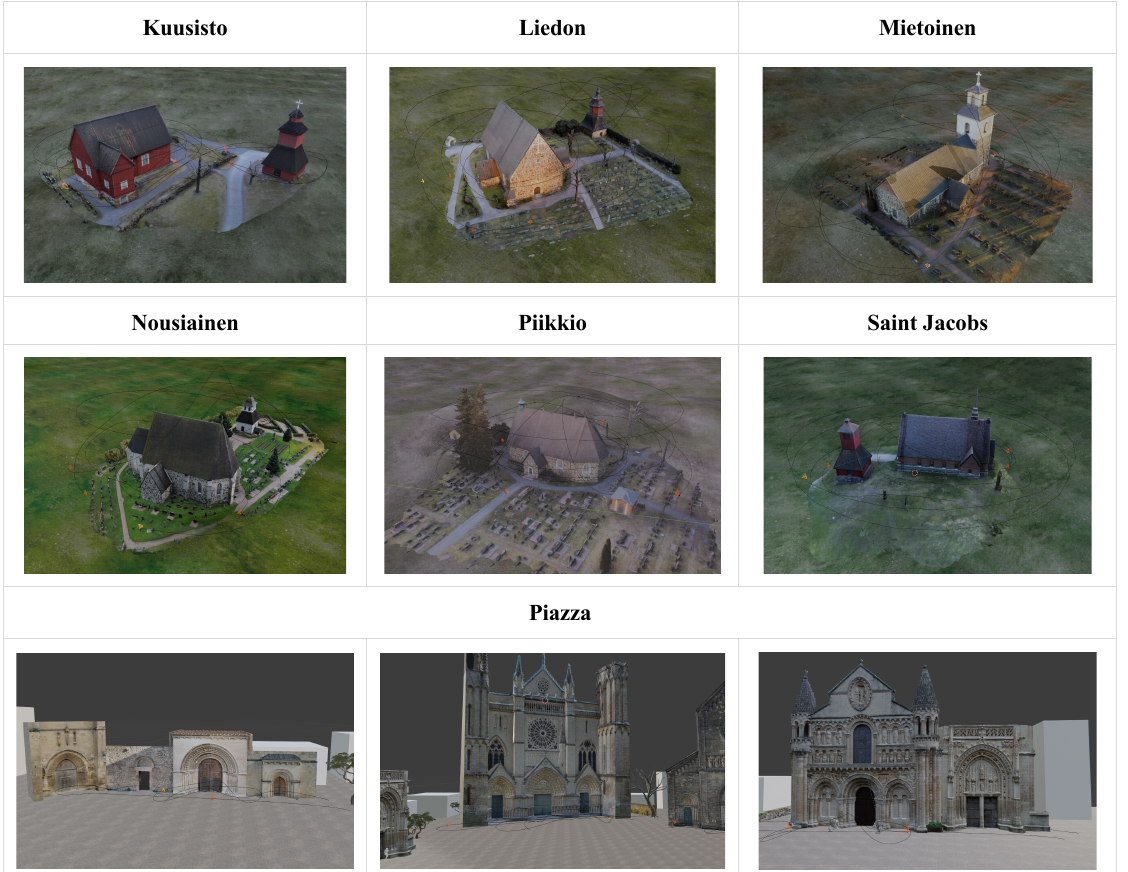
Figure 2. Our synthetic dataset ArchDepth. The first six scenes depict 3D models of churches, while the last scene includes several historic facades. The diverse camera paths for each scene are indicated with a black